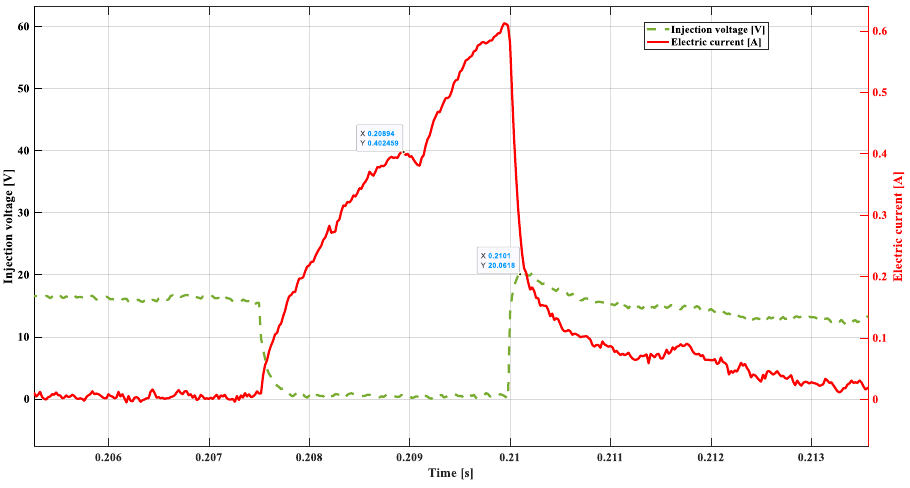
Figure 14. Short circuit using a 20 Ω resistor, 800 rpm.